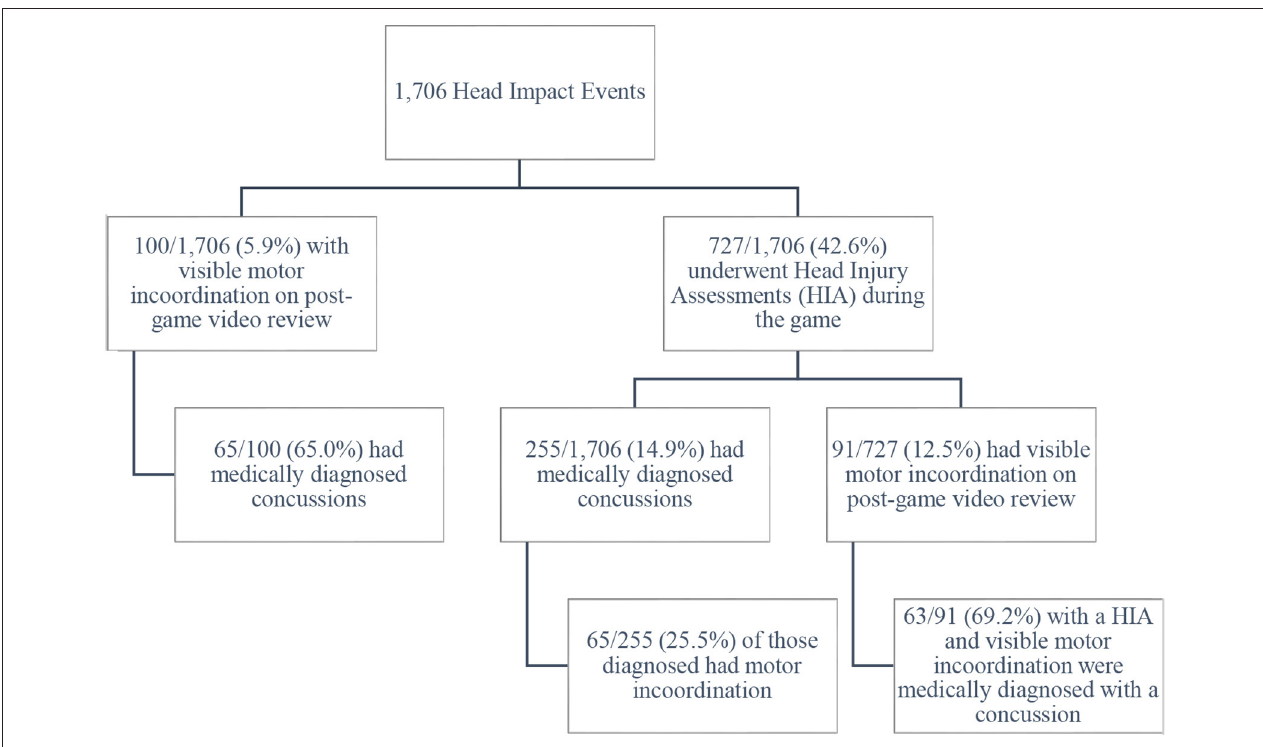
FIGURE 1 | Onfield motor incoordination following head impacts. Nine Head Impact Events were not followed by Head Injury Assessments but were ultimately associated with medically diagnosed concussions. This explains the two different denominators in the bottom corners of the flow diagram (100 and 91).